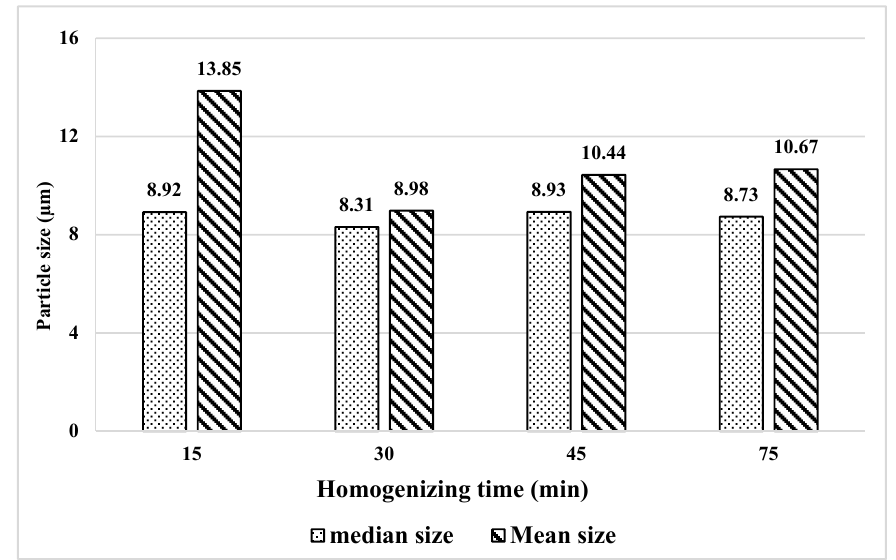
Figure 3. Effect of different homogenization durations on particle size of suspensions. Figure 3. E ff ect of di ff erent homogenization durations on particle size of suspensions. Figure 4 represents variations of particle size with respect to di ff erent curcumin